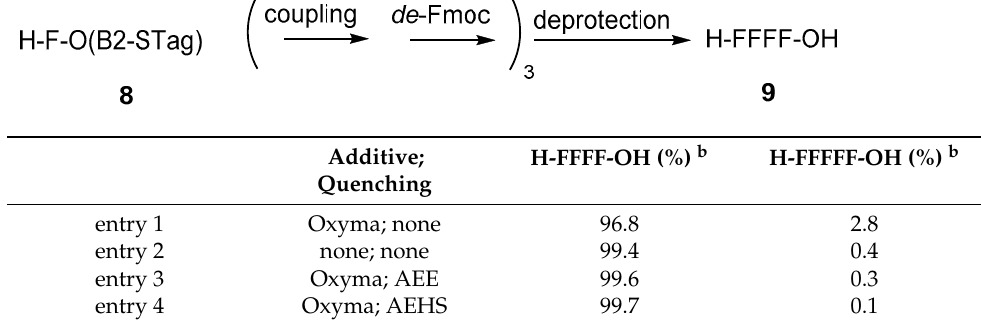
Table 3. Suppression of the double hit by quenching a .